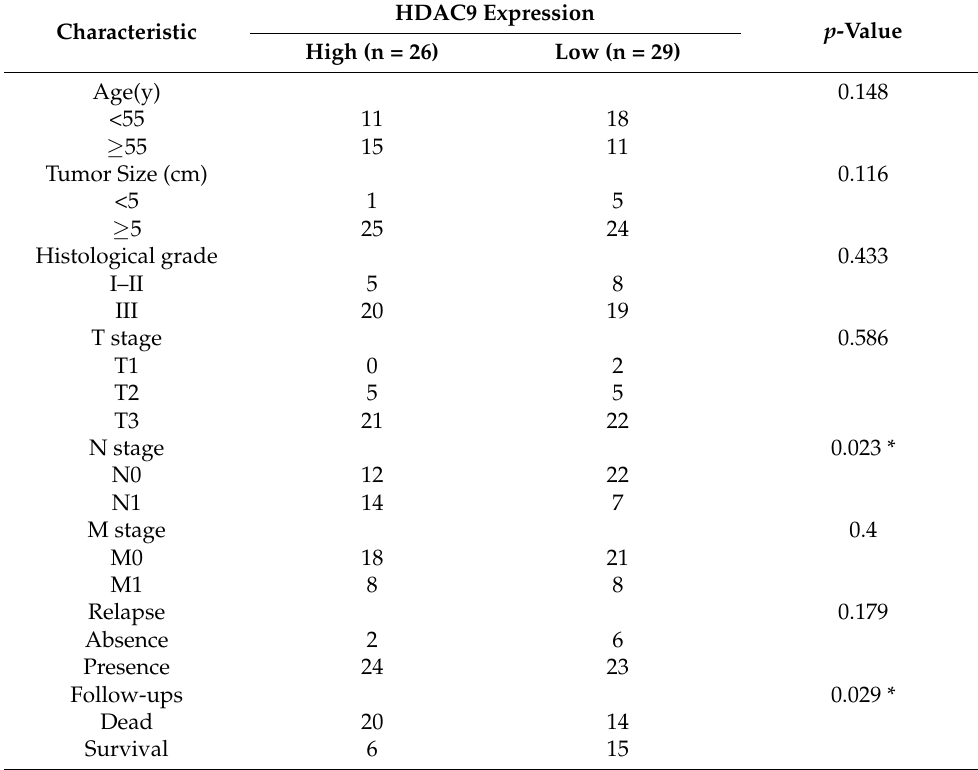
Table 1. Clinical pathological characteristics of serous ovarian cancer